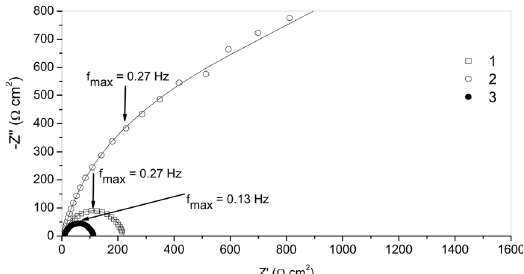
Figure 5. Nyquist diagram of the coatings produced using Solution 2 under the conditions described in Table 1: (1) Experiment 1;